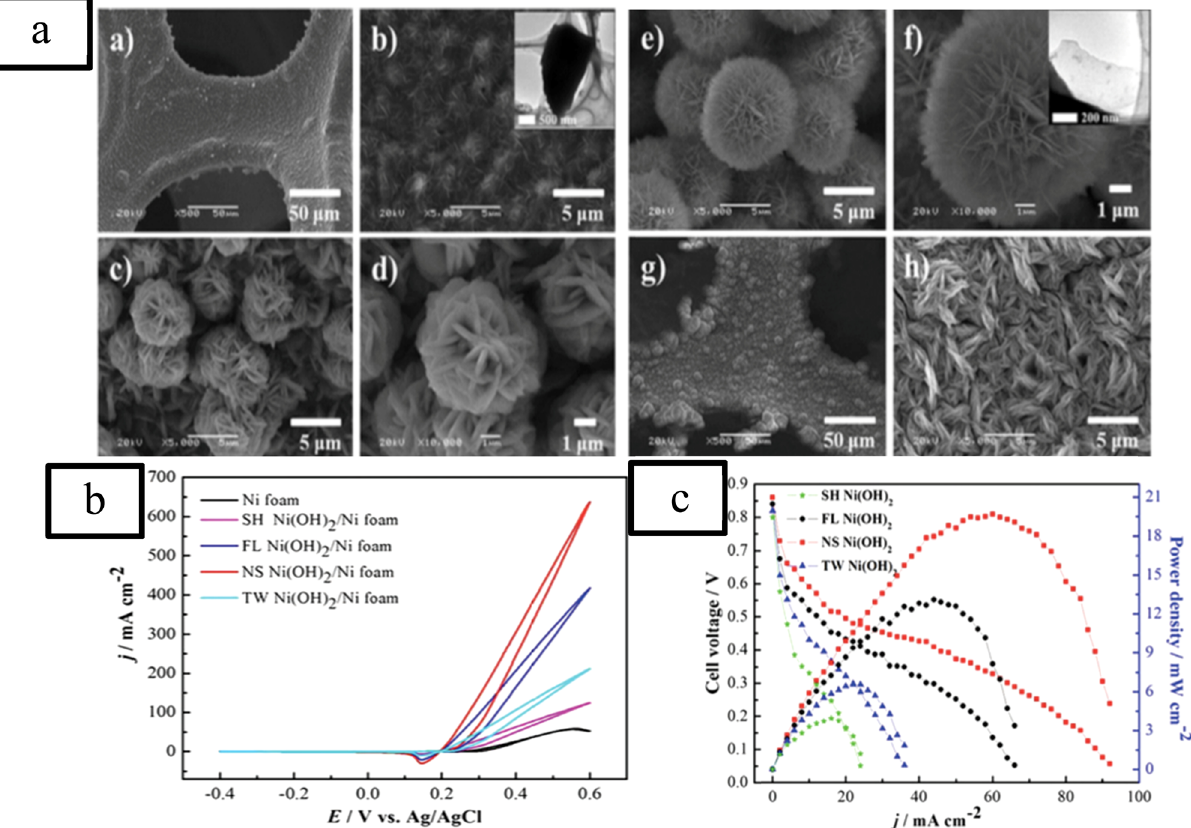
Figure 7: SEM visualization of sheet - like (( a and b ) ; fl ower like ( c and d ) ; nanosheets ( e and f ) ; and twin - like ( g and h )) ( a ) ; the CVs of various morphologies of Ni ( OH ) 2 /Ni foams ( b ) and the DUFC performances using all morphologies ( c ) , republished with permission of Royal Society of Chemistry, from [ 74 ] ; permission conveyed through Copyright Clearance Center,